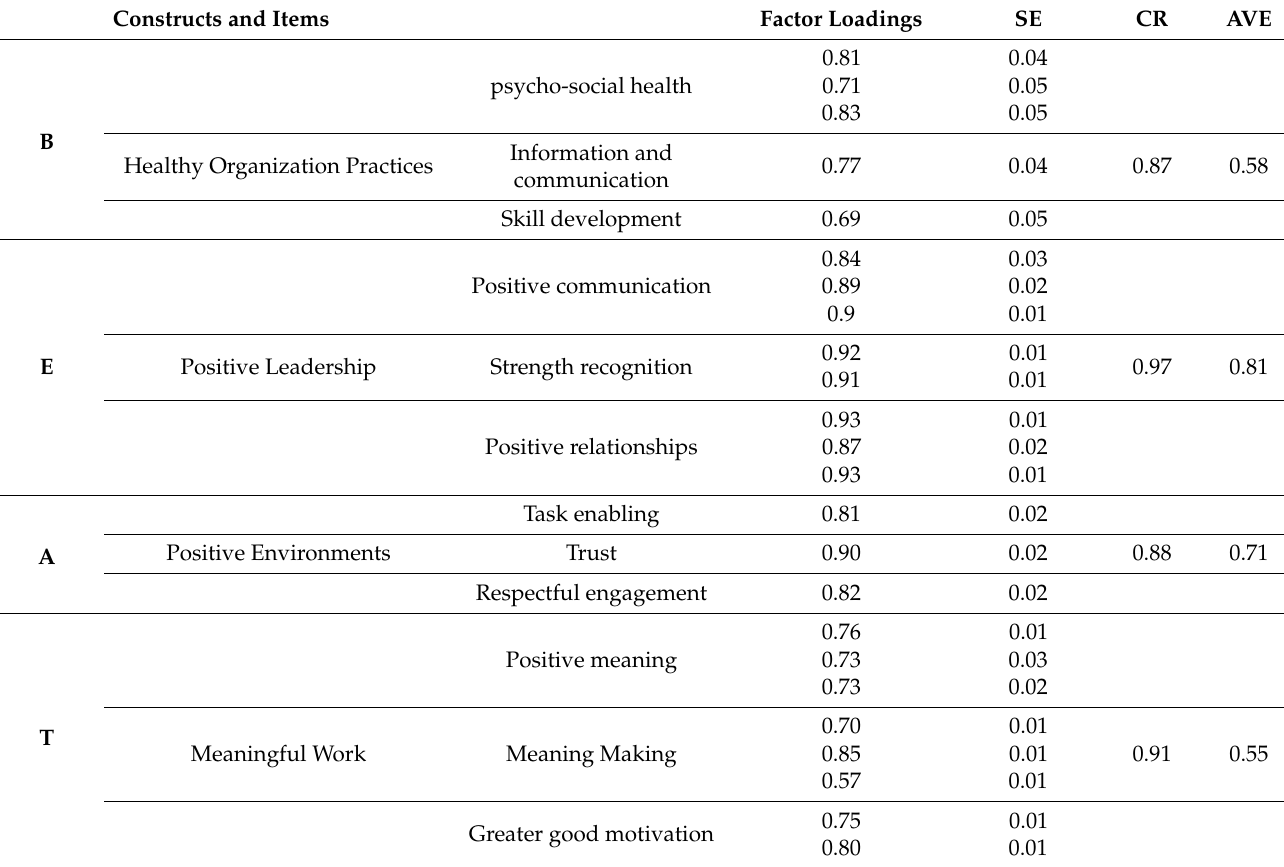
Table 3. Overall Confirmatory Factor Analysis (CFA) for the BEAT Measurement